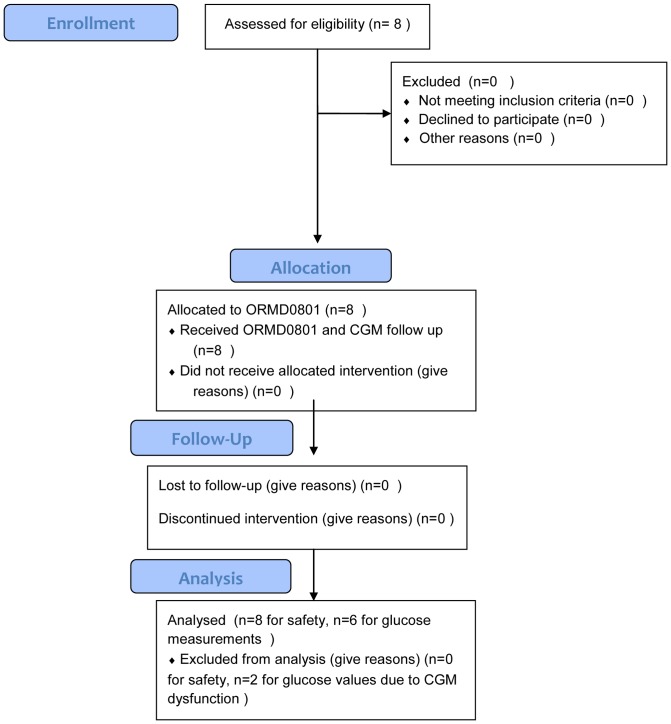
Study flow diagram.